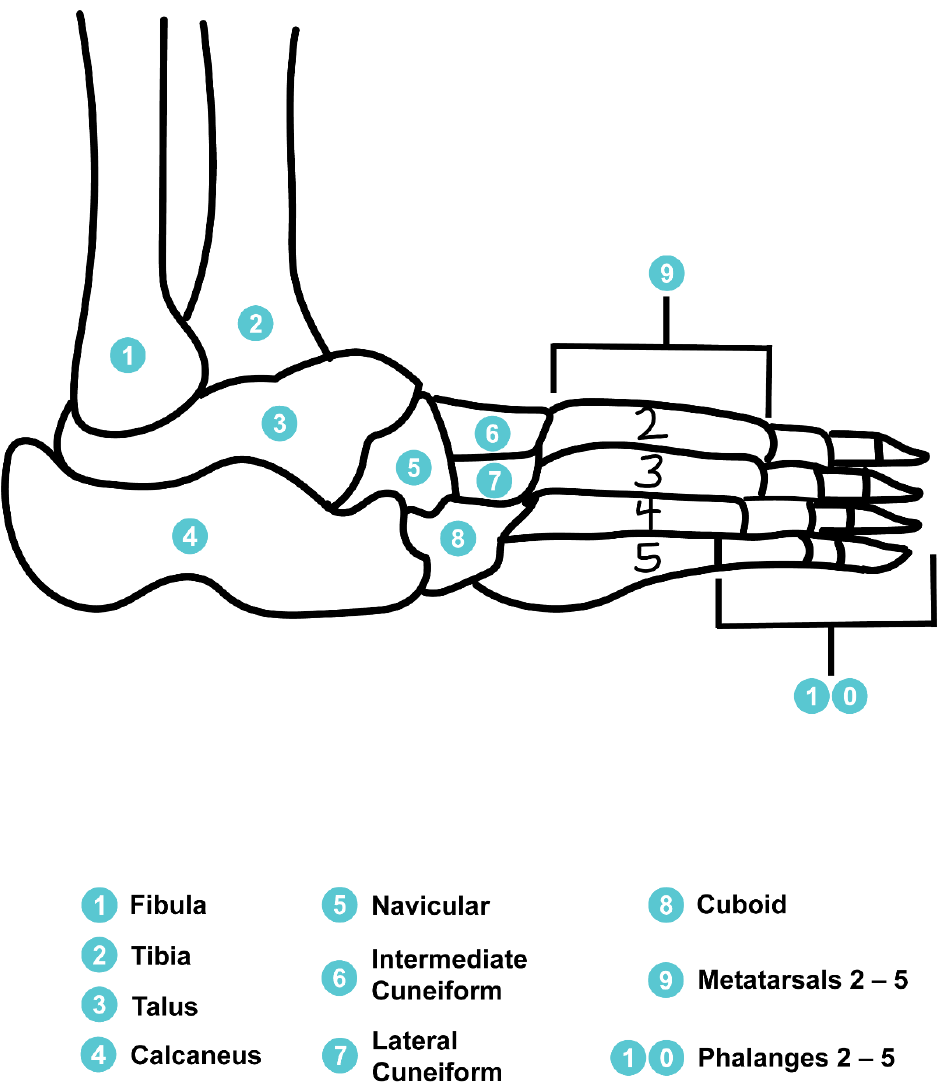
Figure 1. Lateral view of the osteology of the foot-ankle complex. Several bones including the medial cuneiform, first metatarsal, and first phalanges are not